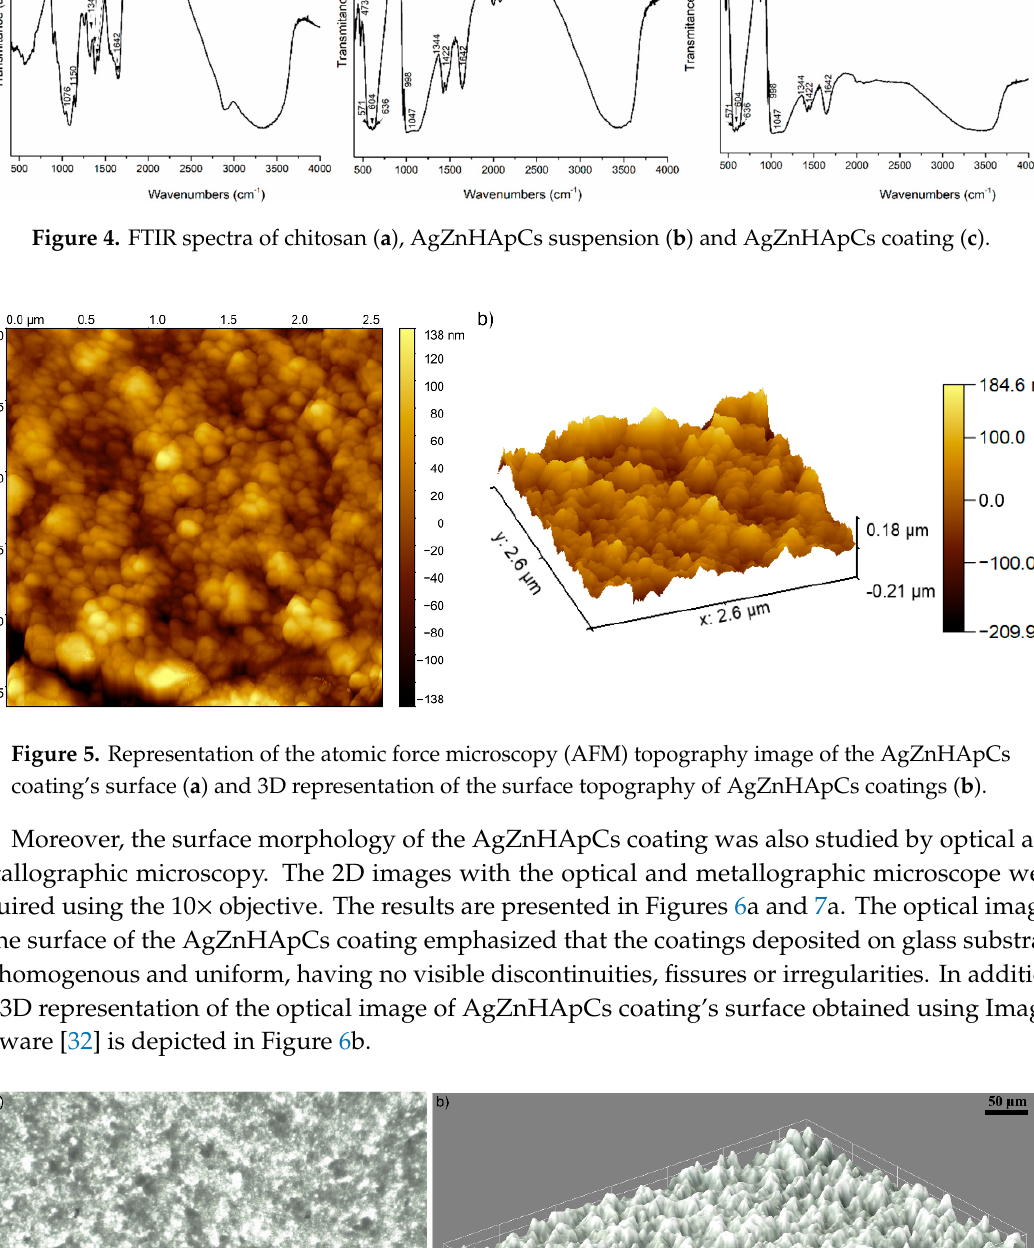
Figure 4. FTIR spectra of chitosan ( a ), AgZnHApCs suspension ( b ) and AgZnHApCs coating ( c ).